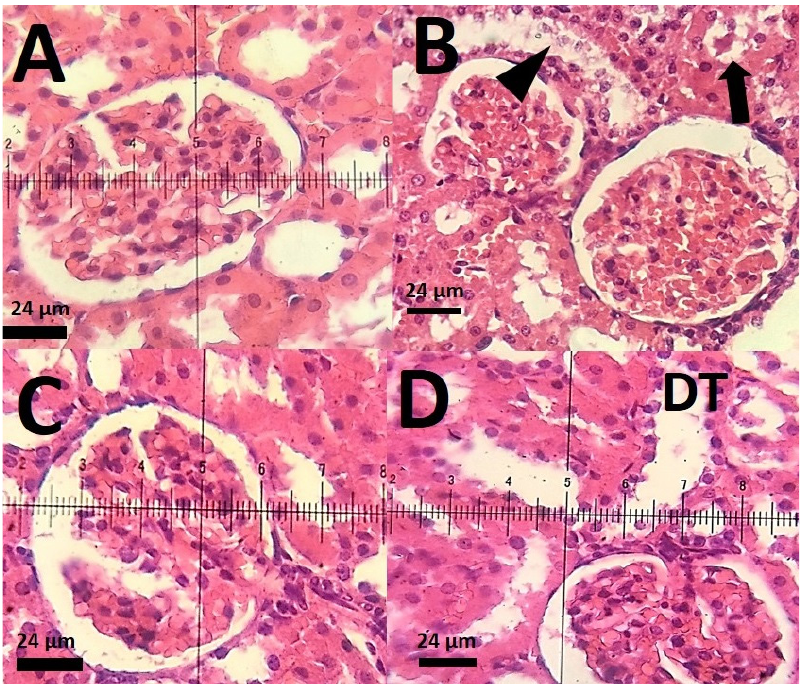
Figure 6. (A): Light micrograph of the kidney of a control rat; normal glomerulus (G), Bowman capsule (Bc), proximal tubules (PT), and normal distal tubules (DT). Light micrograph of a kidney section of a rat treated with Se powder (B): Cytoplasmic vacuolation (arrow point), and hyaline cast (arrow) (C): Light micrograph of a kidney section of a rat treated with Se NPs. D: Normal renal histopathology; Light micrograph of a kidney of a rat treated with Se NCs. Normal renal structure (arrow point) (H & E stain. Mic. Mag. × 40).